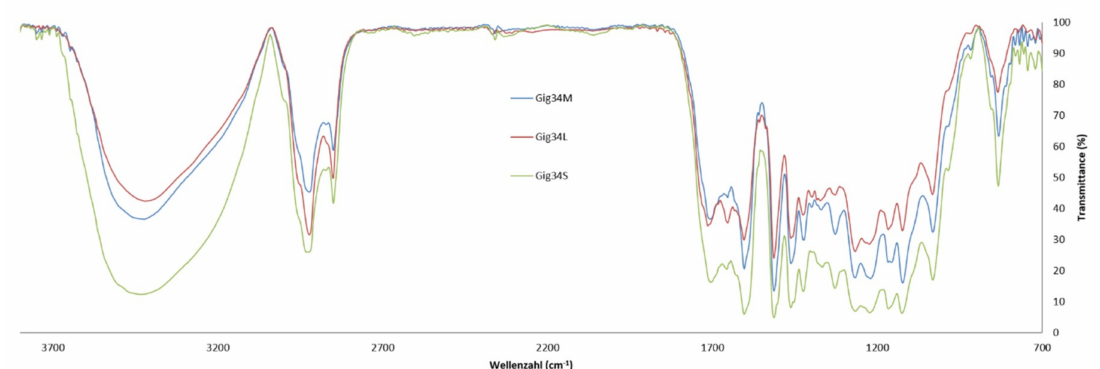
Figure 5. FT-IR spectra of mixture (Gig34M), leaf (Gig34L), and stem-derived (Gig34S) lignins obtained from M . x giganteus